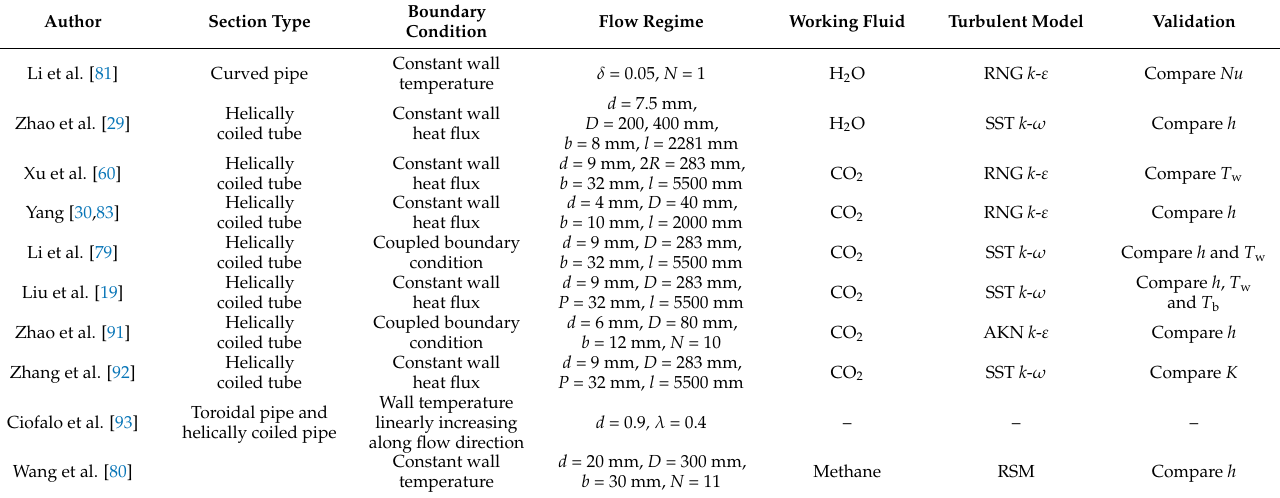
Table 2. Summary of the available numerical studies on supercritical fluids in curved